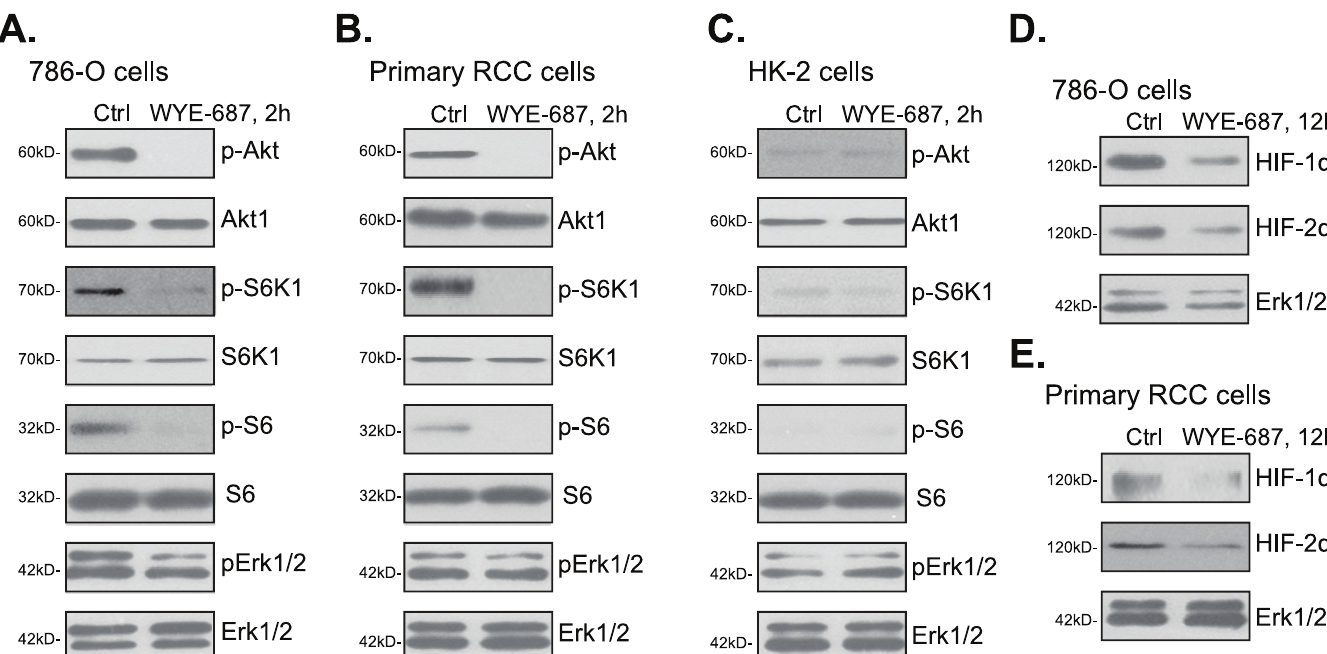
Fig 4. WYE-687 blocks mTORC1 and mTORC2 activation in RCC cells. 786-O cells (A and D), primary humanRCC cells (B and E), or HK-2 tubular epithelialcells (C) were treated withWYE-687 (100 nM) for appliedtime, expressionof listed proteins was tested by Western blot assay.